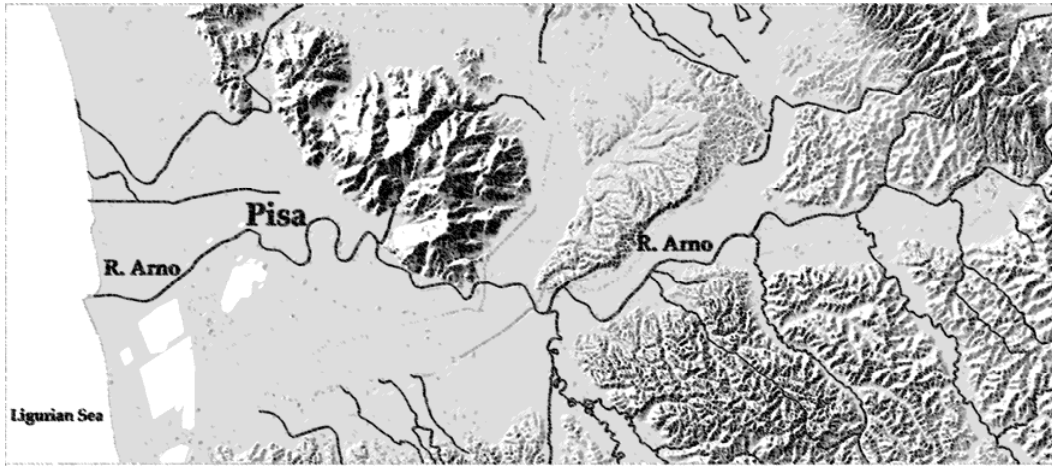
Figure 2. Morphological map of the study area. The scale is the same as the previous figure. (Adapted from: Tuscany Region Database–Geoscopio [10]).